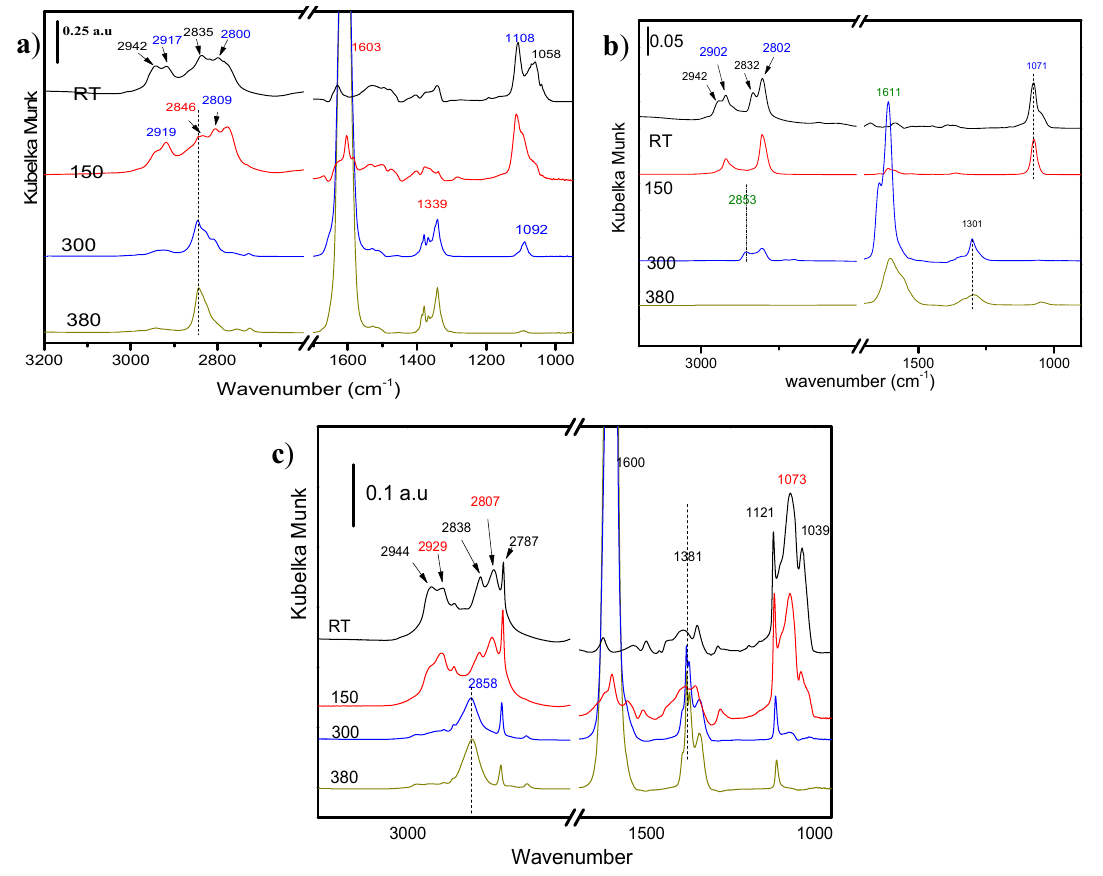
Figure 5. Methanol desorption spectra on ( a ) MgO, ( b ) Fe 2 O 3 , and ( c ) impregnated FeO x /MgO_1_10 samples.